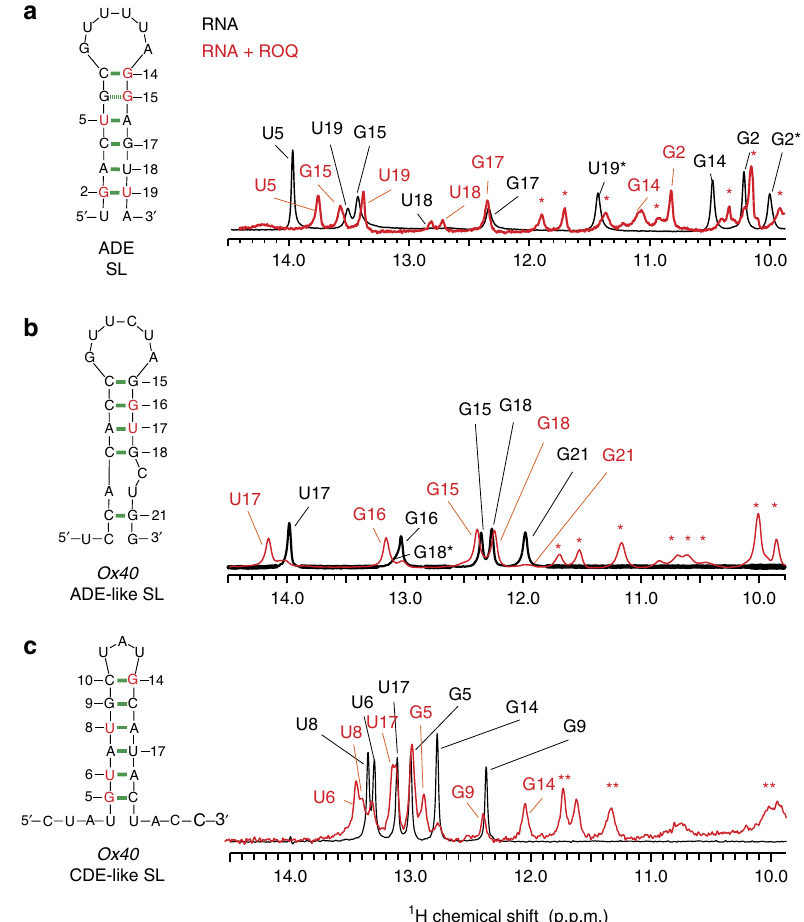
Figure 2 | NMR analysis of the SL RNAs used in this study. Imino proton regions of one-dimensional 1 H NMR spectra of ( a ) the ADE SL ( b ), the Ox40 ADE-like SL and ( c ) the Ox4 0 CDE-like SL are shown for free RNAs (black) and in complex with the Roquin-1 ROQ domain (red). The respective SL RNAs and their base pairs are indicated. Red asterisks indicate NMR signals of the protein. Black asterisks in a indicate a second conformation (see Supplementary Notes). Green lines in the secondary structure schemes on the left refer to visible imino NMR signals and thus experimental confirmation of the base pairs indicated. Red nucleotides indicate significant chemical shift changes observed. The dotted green line between G6 and G15 in a highlights a G–G base